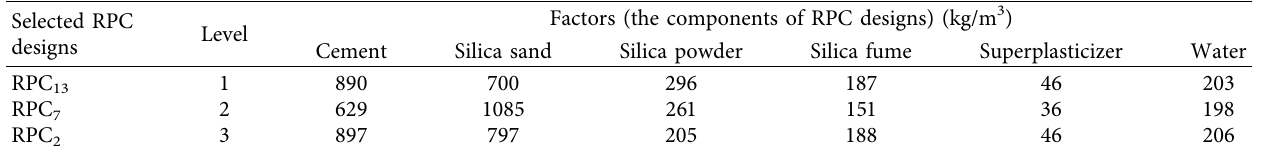
Table 11: Factors of selected